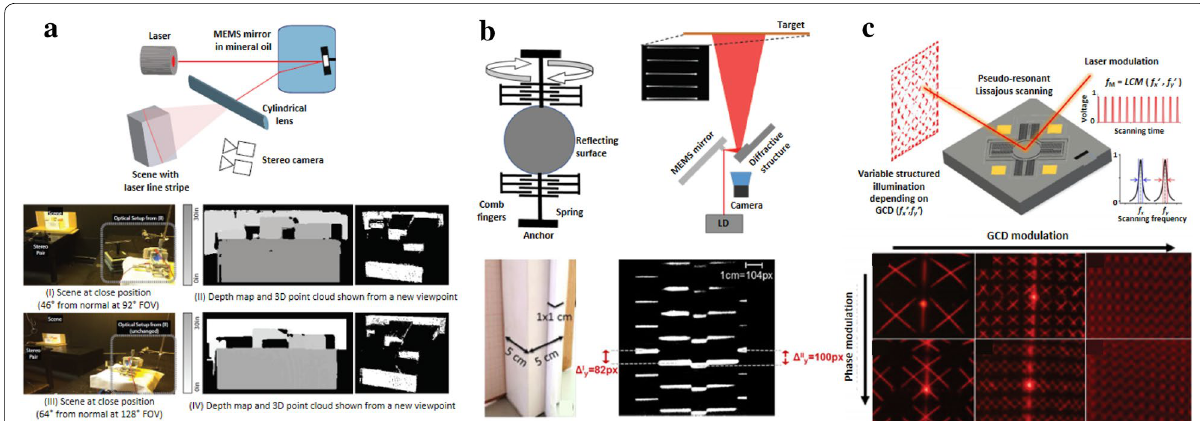
Fig. 3 Structured light pattern generation system by scanning the MEMS mirror for 3D surface imaging; a wide‑angle structured light generation with 1D MEMS mirror immersed in liquid and its 3D imaging results with the pattern generation FOV over 90 ° [31]. b Line array projector consisted of a 1D scanning MEMS mirror and a diffractive microstructure and the estimation of the depth profile of the object by calculating the line deformation [32, 33]. c Variable structured illumination using Lissajous scanning MEMS mirror and optical patterns from the projector module with different GCD and phase